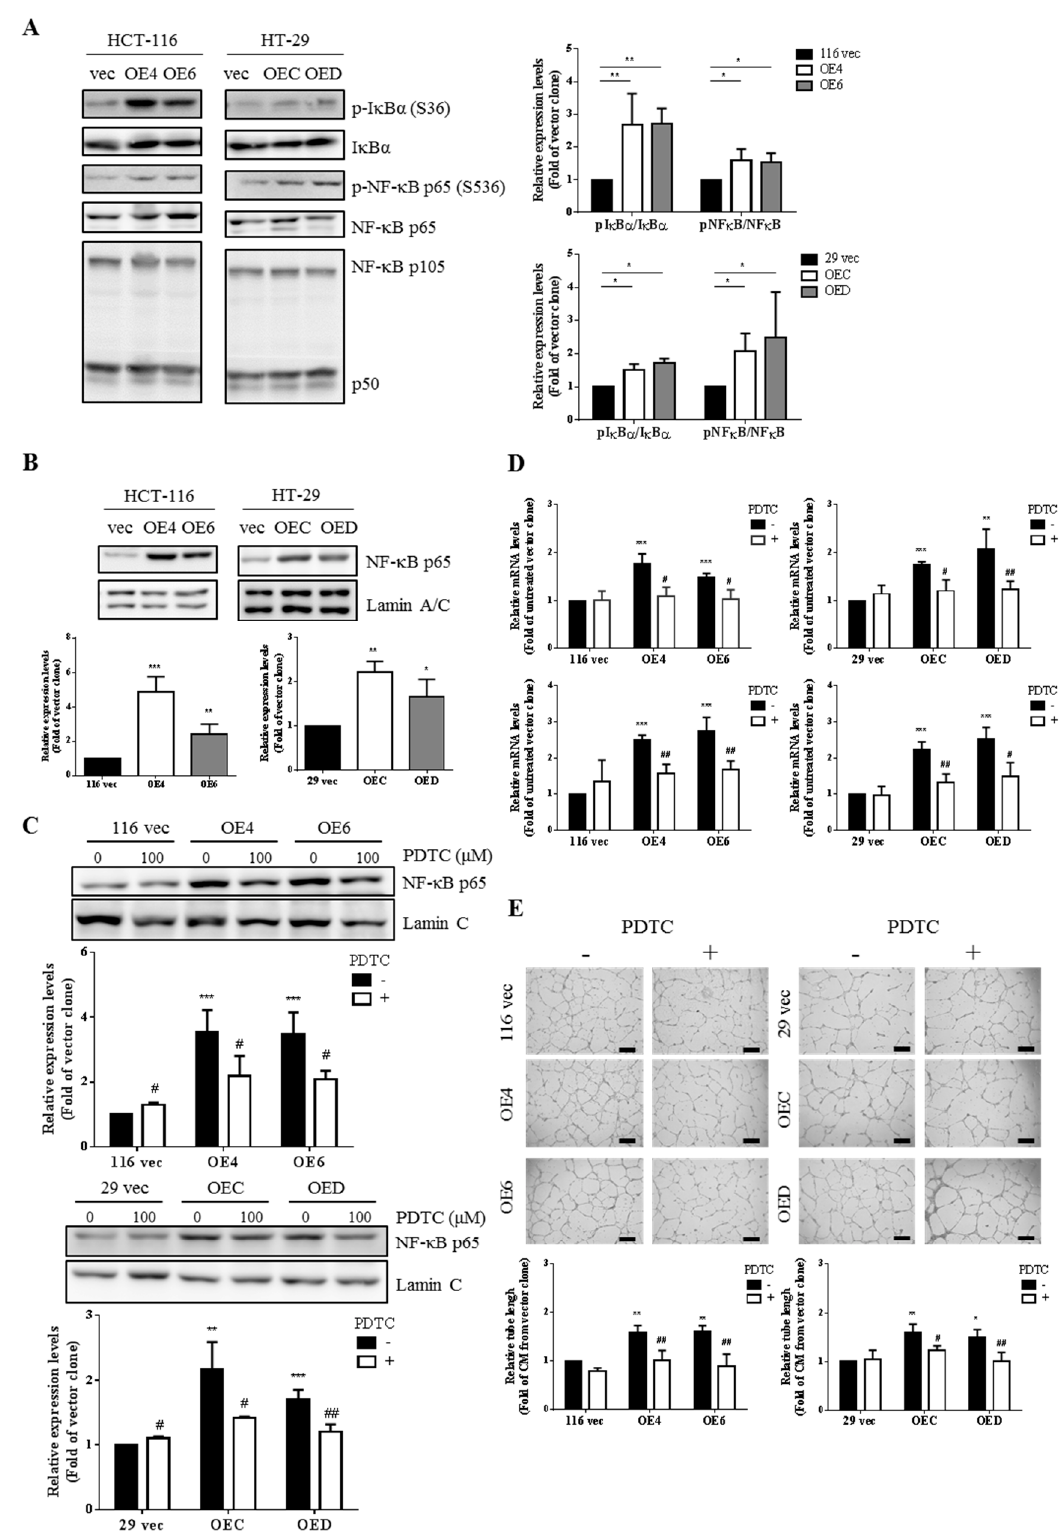
Figure 4. Activation of the NF- κ B pathway in the GATA6-overexpressing clones is responsible for higher production of VEGF-A and IL-8 by them. ( A ) Total lysates (20 μ g) prepared from three clones derived respectively from HCT-116 and HT-29 cells were subjected to western blot analyses using primary antibodies against p-I κ B (ser36), total I κ B, p-NF- κ B p65 (ser536), total NF- κ B p65, and NF- κ B p105/50 as probes, respectively. The quantitative results (right panels) obtained by densitometry are the mean ± SD of three independent experiments. * p < 0.05 and ** p < 0.01 compared with the respective vector clones by Student’s t -test. ( B ) Nuclear fractions (20 μ g) prepared from three clones derived respectively from HCT-